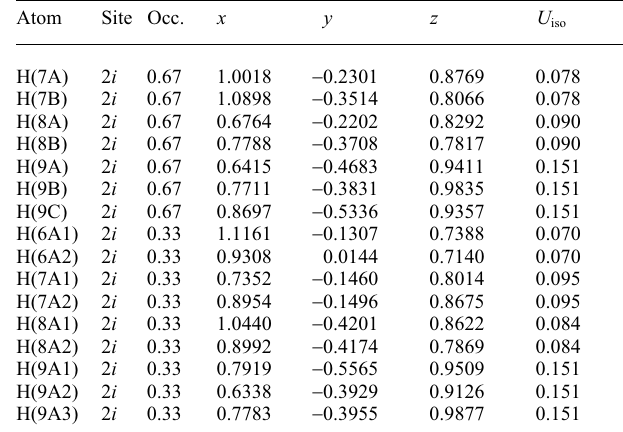
Table 2. Atomic coordinates and displacement parameters (in Å 2 ) . Atom Site